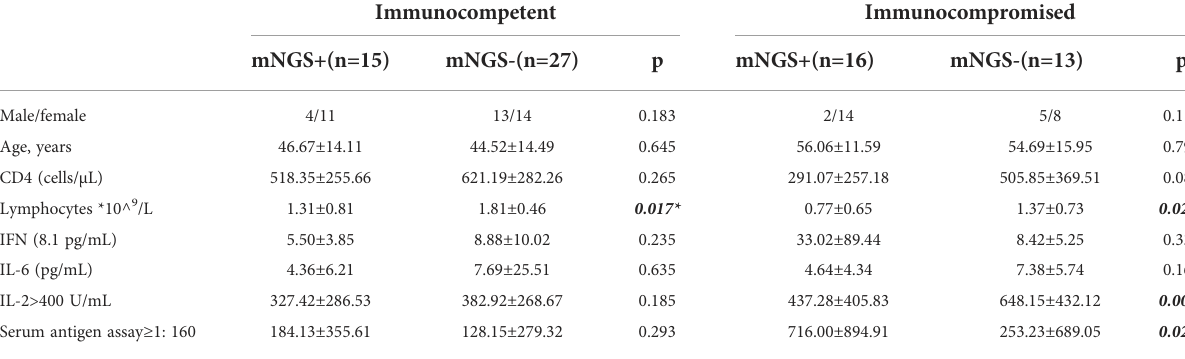
TABLE 1 Relationship between positive mNGS results and laboratory indexes in patients with different immune statuses.